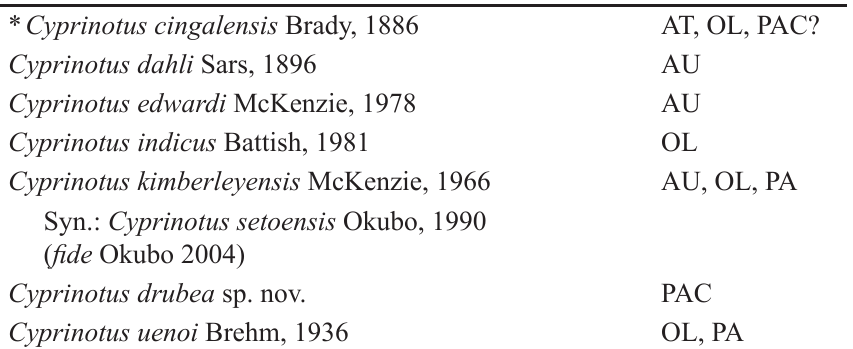
Table 2 . Species retained in Cyprinotus s. str. (* = type species). AT: Afrotropical; AU: Australasian; OL: Oriental; PA: Palaeartic; PAC: Pacific Oceanic